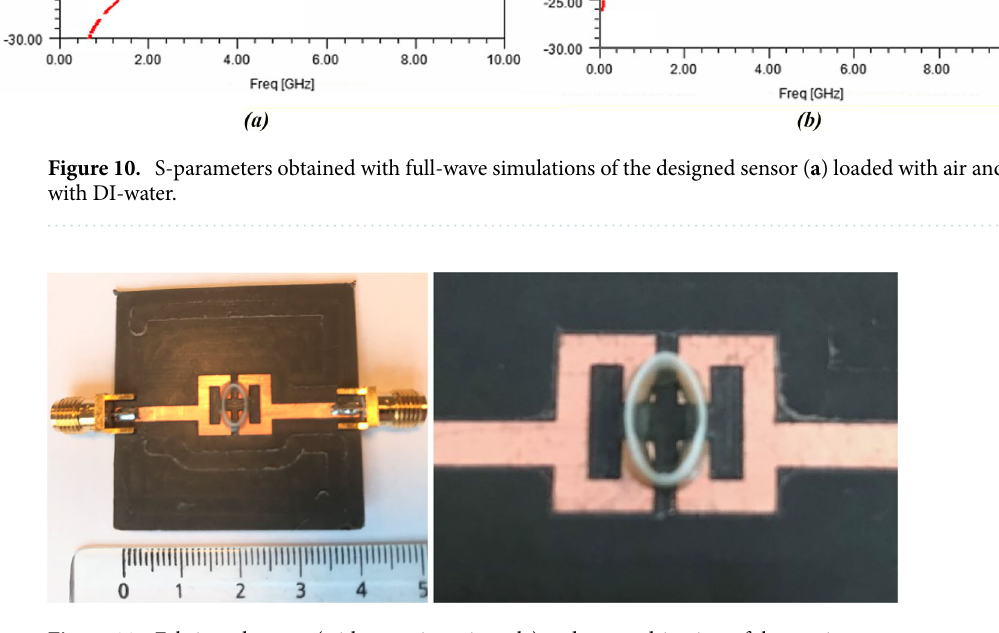
Figure 11. Fabricated sensor (with a centimetric scale) and zoomed-in view of the sensing